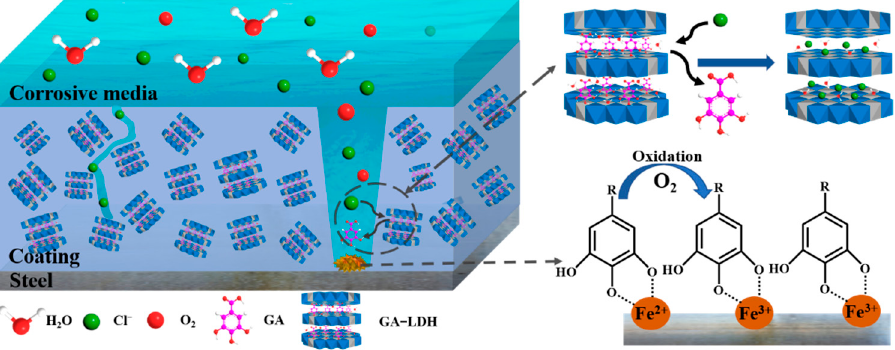
Figure 12. Schematic diagram of the corrosion protection mechanism of the GA − LDH/EP coating.